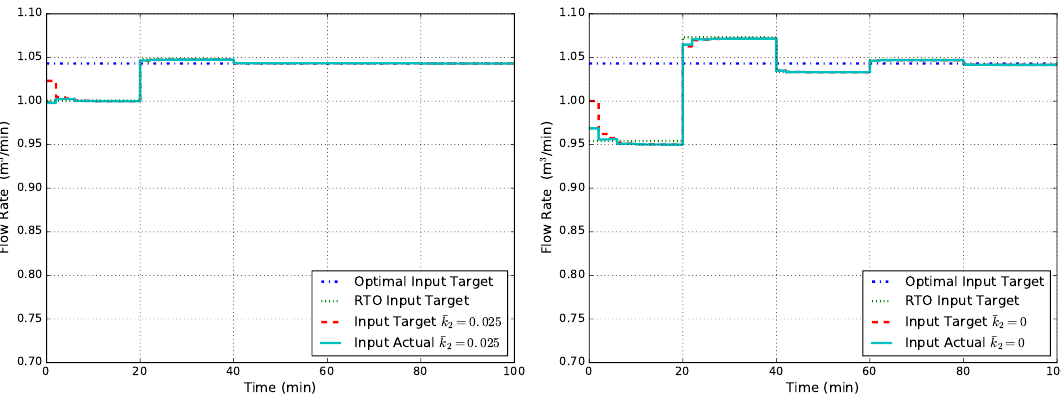
Figure 5. Closed-loop flow rate Q obtained with modified RTO followed by tracking MPC with the output disturbance model for two cases of uncertainty in k 2 : ¯ k 2 = 0.025 ( left ) and ¯ k 2 = 0 ( right